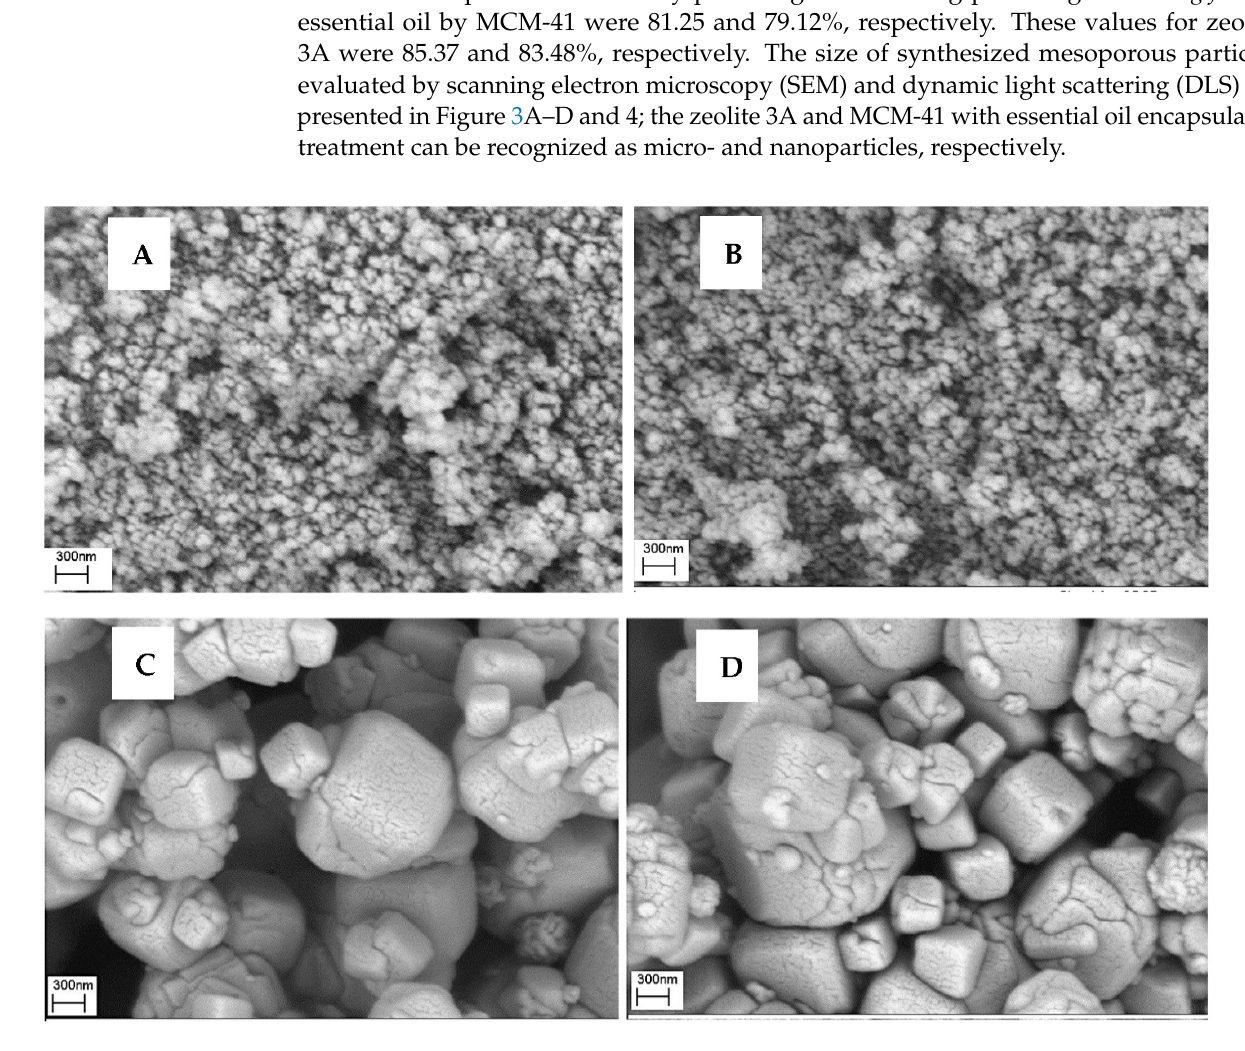
changed from 151 to 157 nm and 272 to 308 nm, respectively, as a result of loading of es-